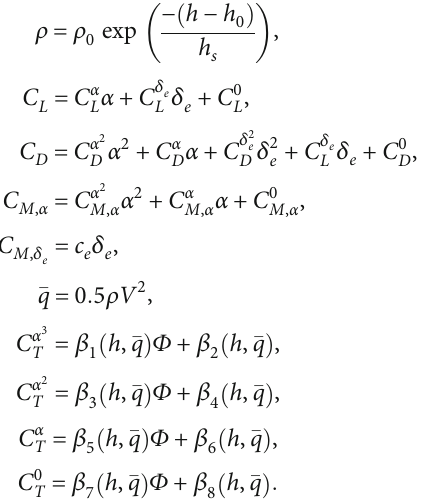
Table 1: Nomenclature and nominal